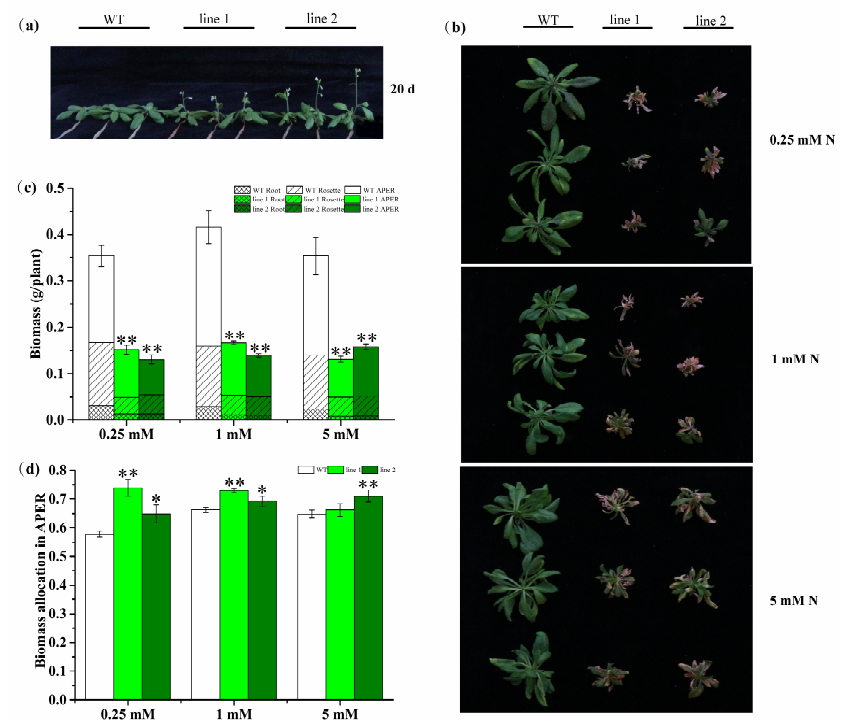
Figure 5. Comparison of growth performance between CsATG8e- overexpressed Arabidopsis (OE) and wild-type (WT) plants. ( a ) Growth of the WT and CsATG8e OE Arabidopsis after a 20-day culture at the su ffi cient N condition. ( b ) The rosette of OE and WT Arabidopsis after a 20-day culture under su ffi cient N, followed by another fourteen-day culture under di ff erent N levels. ( c ) The comparison of biomass in aerial part excluding rosette (APER), rosettes (Rosette) and roots (Root) between OE lines and WT. ( d ) The allocation of biomass in APER. 0.25 mM N, 0.125 mM NH 4 NO 3 ; 1 mM N, 0.50 mM NH 4 NO 3 ; 5 mM N, 2.50 mM NH 4 NO 3 . Values are means ± standard (SD) ( n ≥ 6). Asterisks indicate significant di ff erences between WT and two OE lines (line 1, line 2). * p < 0.05; ** p < 0.01 ( t